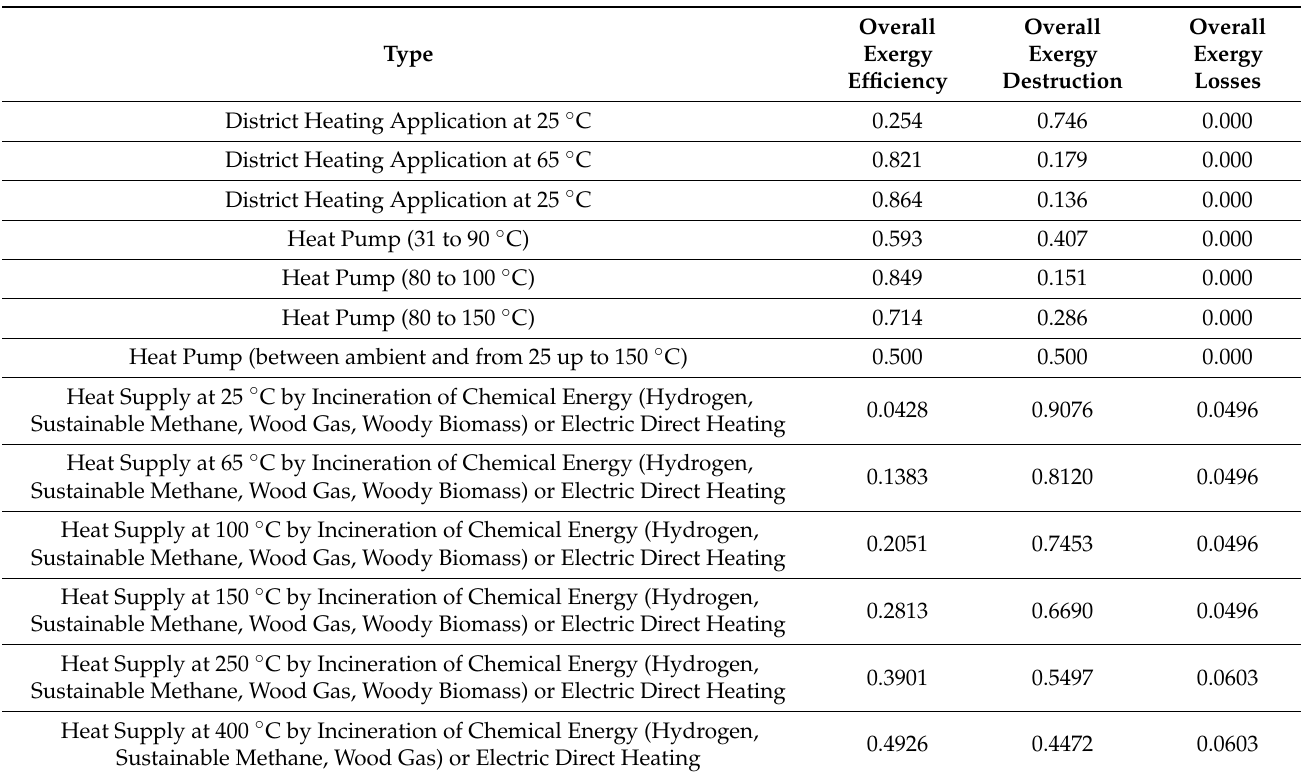
Table A5. Available conversion units for covering heat demand of the scenario Energy Efficiency